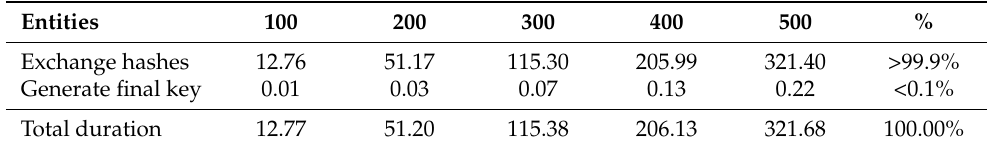
Table 1. Symmetric key generation duration (in seconds) for 100, 200, 300, 400, and 500 entities.